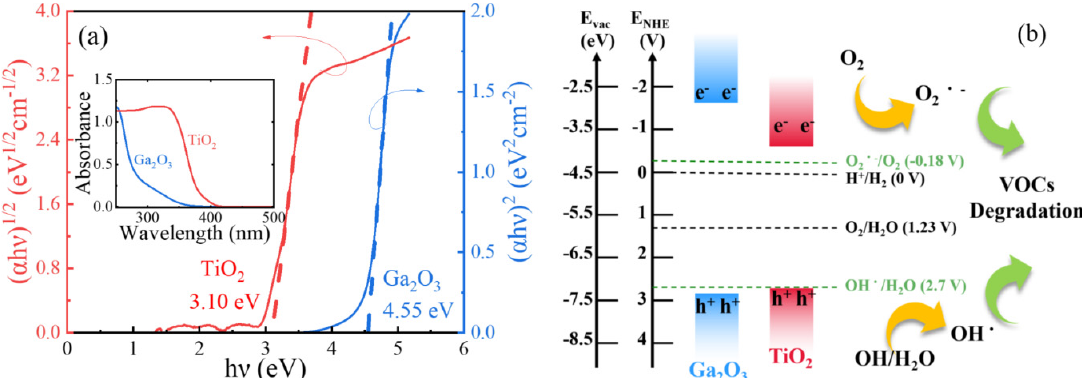
Figure 4. ( a ) Optical absorbance spectra and Tauc plots (direct and indirect bandgap model) for Ga 2 O 3 and TiO 2 , respectively, and ( b ) energy bandgap and band-edge positions of Ga 2 O 3 and TiO 2 along with the redox potentials in the normal hydrogen electrode (NHE) [8] .